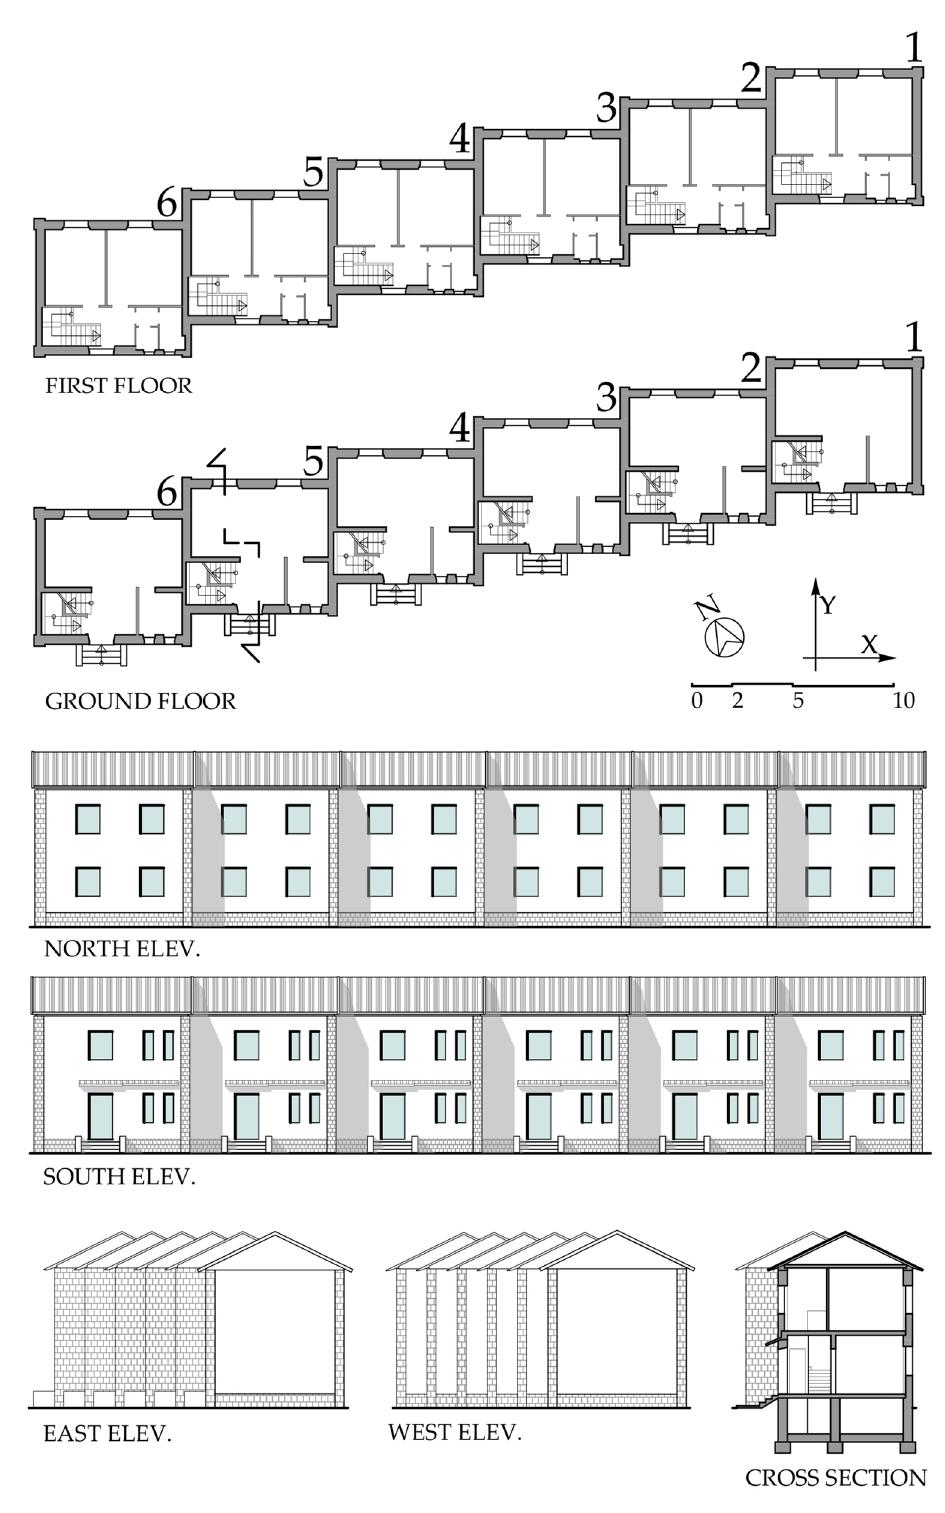
Figure 4. Geometrical survey of IACP building.